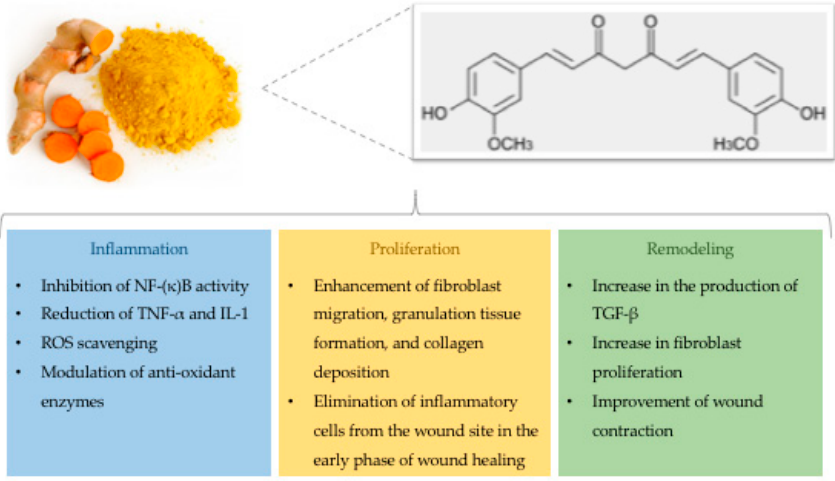
Figure 3. Structure and effects of curcumin on wound healing.